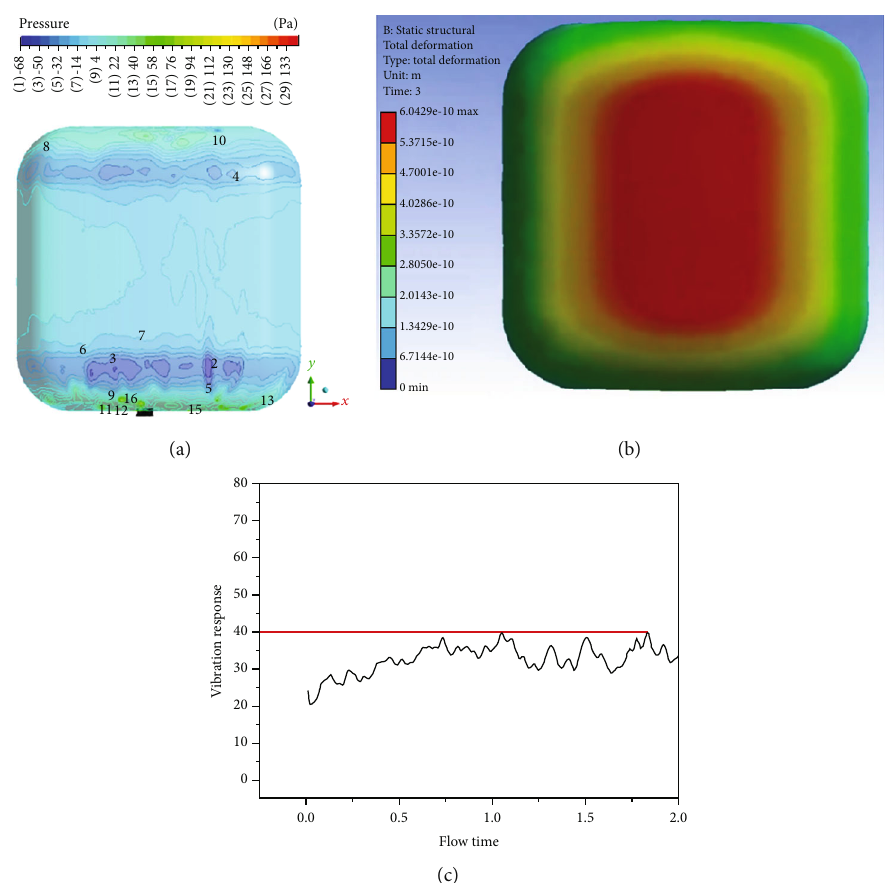
Figure 10: (a) Wind pressure distribution, blue indicates the minimum value and red indicates the maximum value. The gradient of color indicates di ff erent pressures. (b) Displacement diagram, the unit is m. (c) Wind-induced response diagram, the red line indicates the maximum vibration response